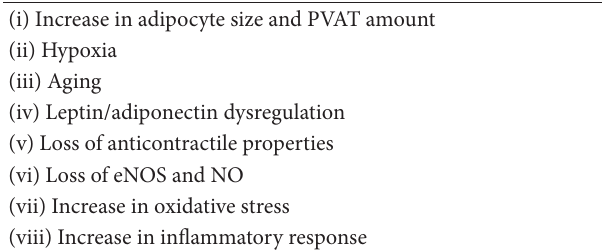
Table 1: Mechanisms of PVAT